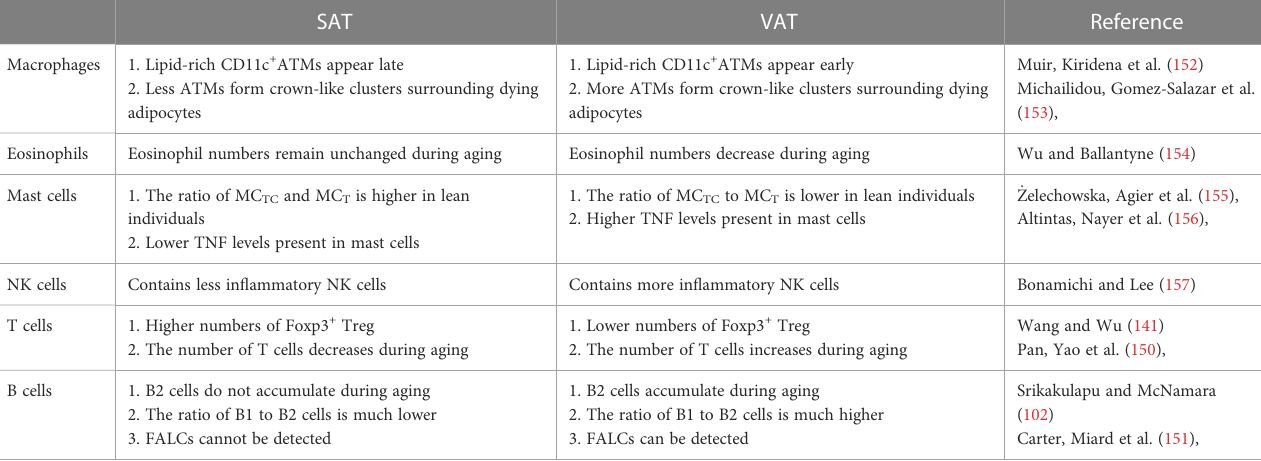
TABLE 2 Comparison of subcutaneous and visceral adipose tissue in fl ammation. SAT